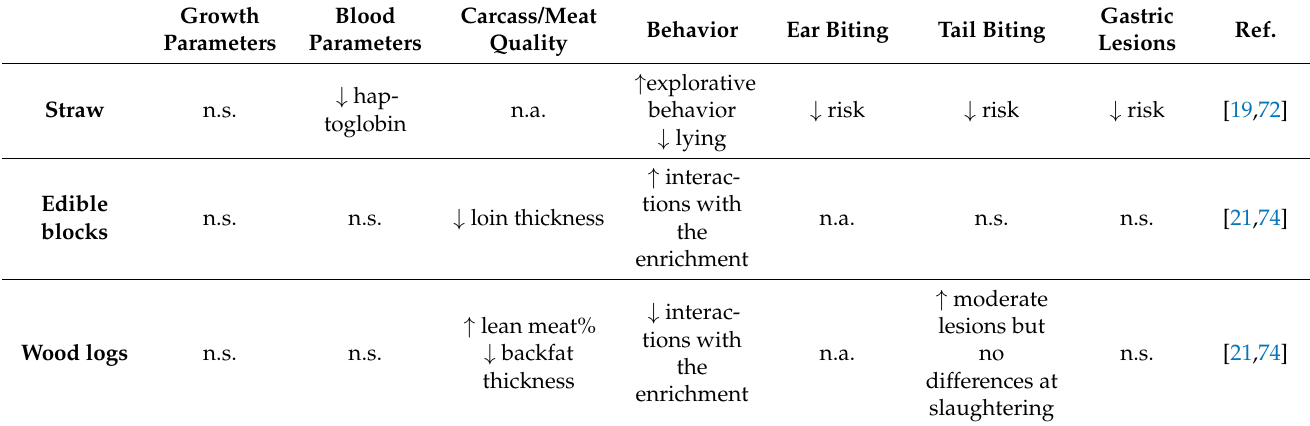
Table 2. Summary of the main findings from studies on environmental enrichments for heavy